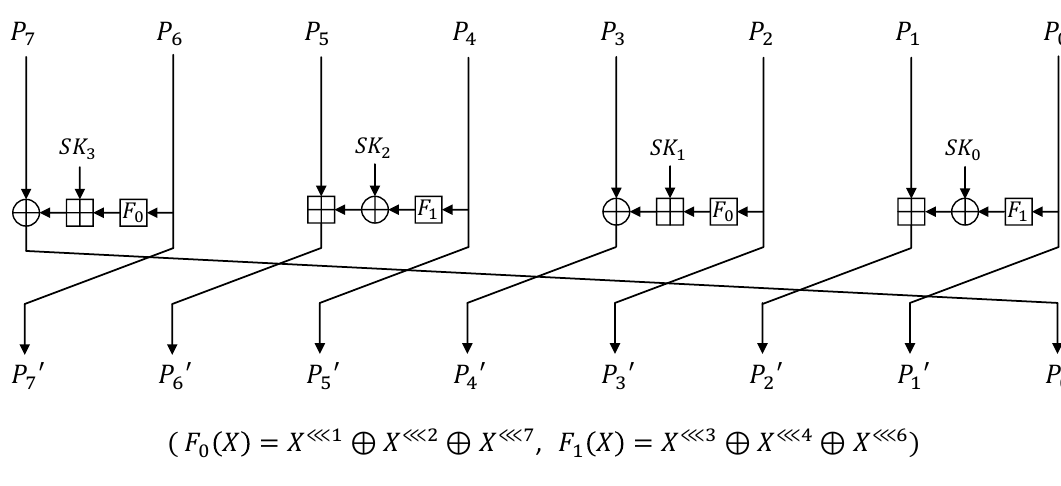
Figure 1. Round function of high security and light weight (HIGHT).